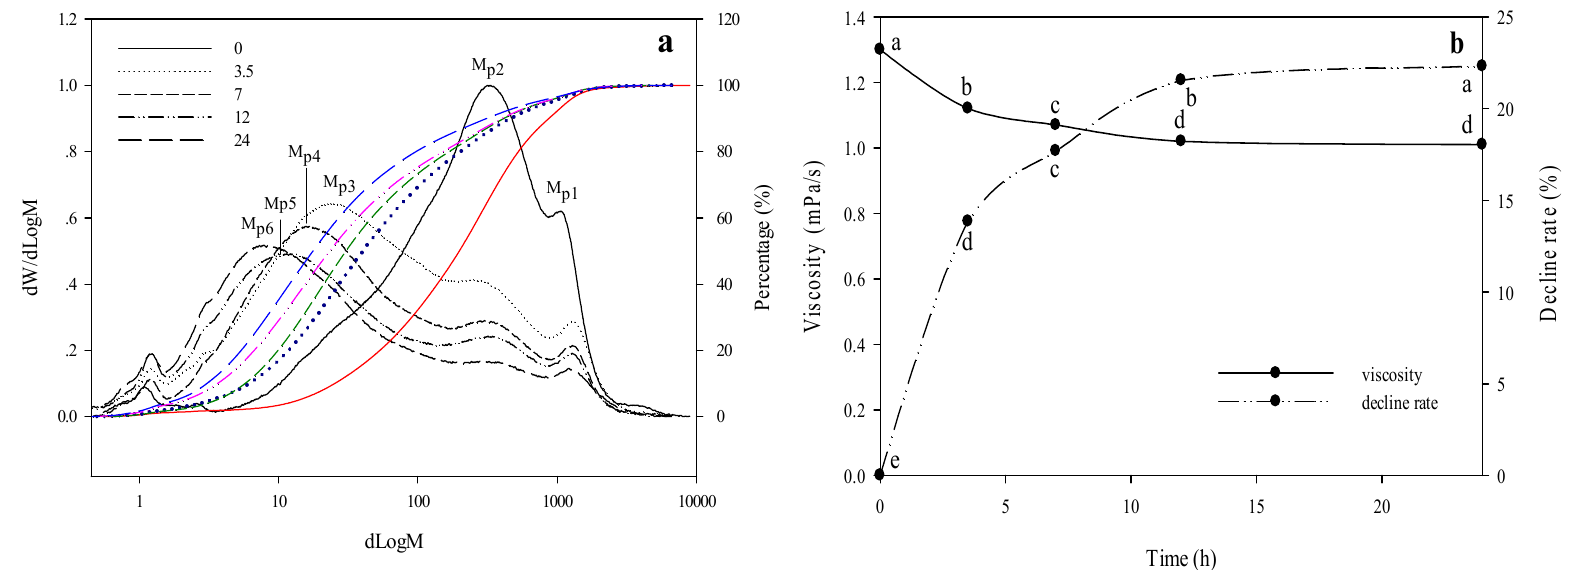
Figure 3. High-performance gel filtration chromatography and the change of viscosity of high-viscosity wheat-derived WEAX after the degradation by endo-1,4- β -xylanase. ( a ) Mw changes of WEAX. ( b ) viscosity changes of WEAX.